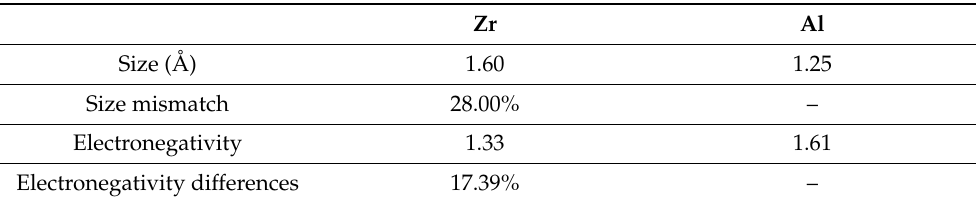
Figure 1. The chemical short-range ordering cluster structure L1 2 -Al 3 Zr. Table 1. The size mismatch and the electronegativity differences between the solute atoms Zr and host Al atoms, data from